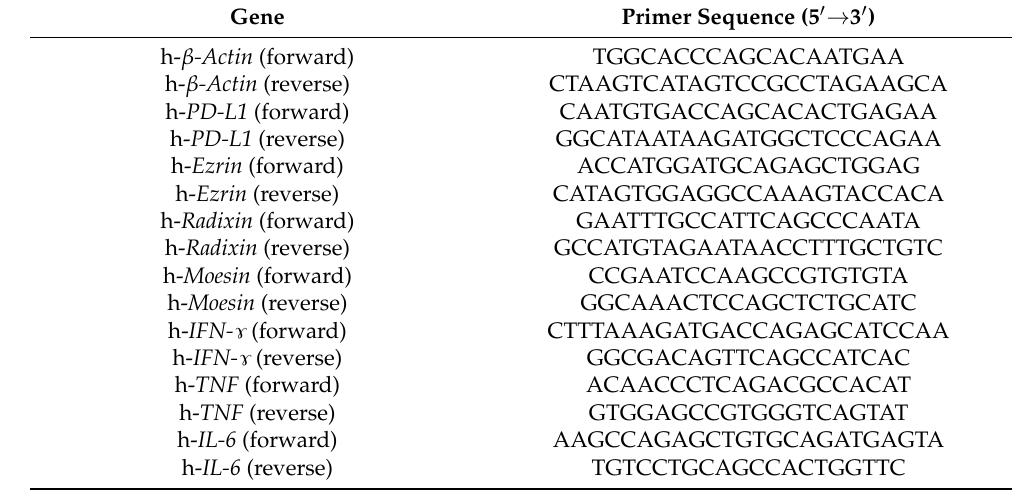
Table 1. Primer sequences used for real-time reverse transcription-polymerase chain reaction analysis.